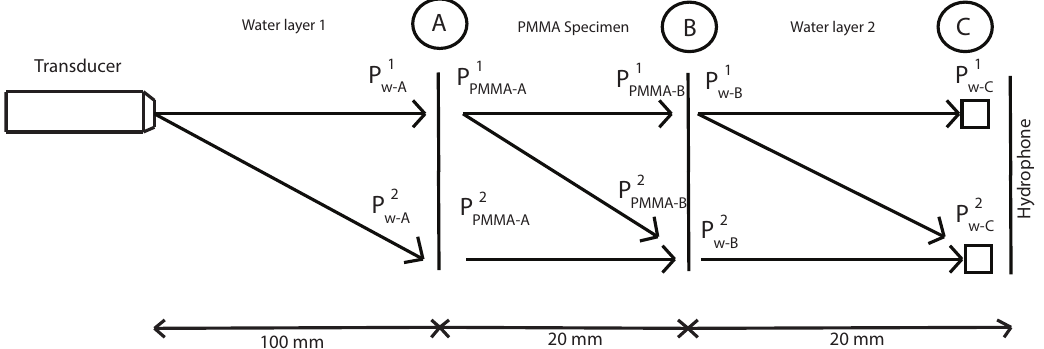
Figure 15. Semi-analytical approach used to extract the nonlinear material’s properties from the measurements in PMMA specimen.